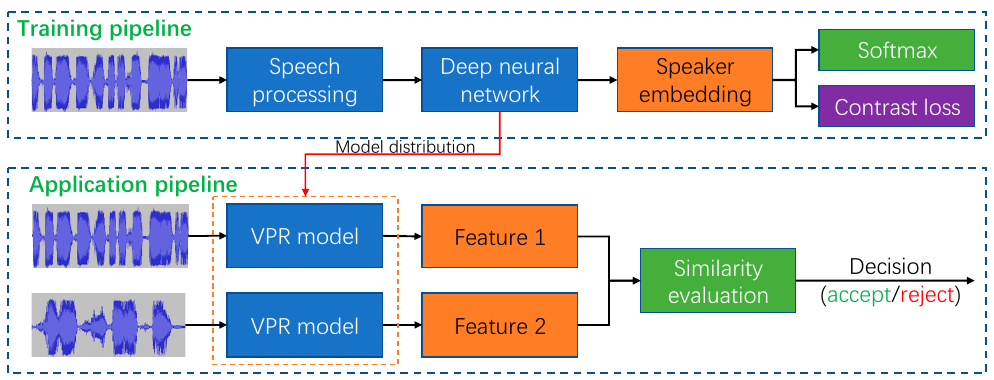
Figure 7. The voiceprint recognition (VPR) pipelines.